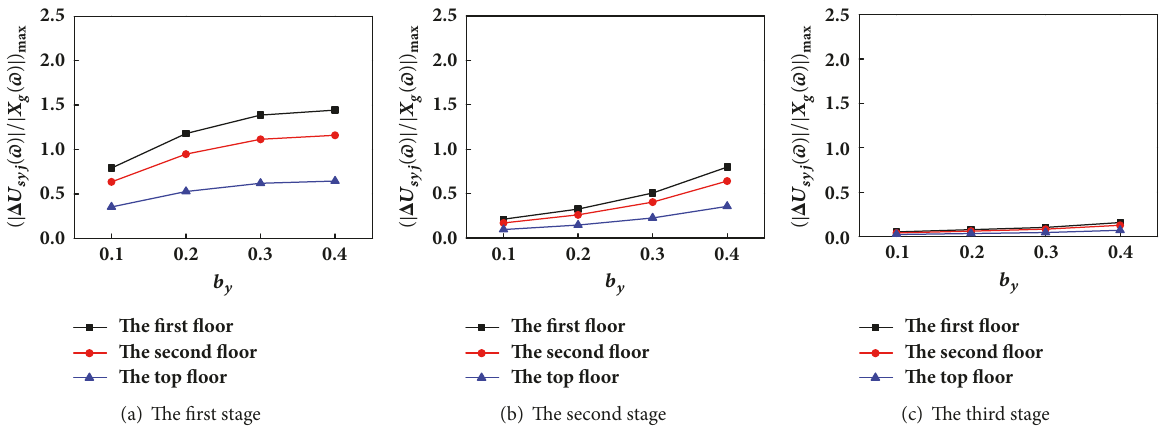
Figure 13: Interstory translation displacement in the 𝑦 direction under different 𝑏 𝑦 values.